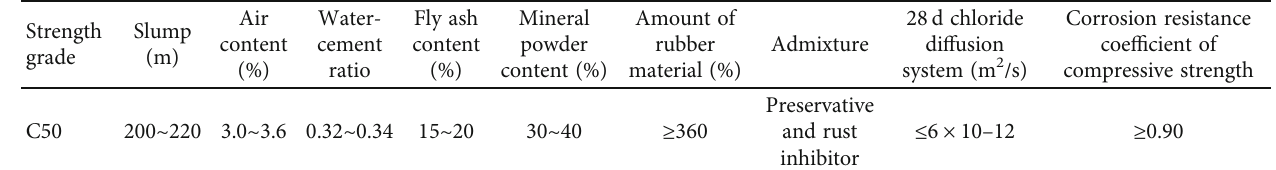
Table 3: Mix proportion design index of the cast-in-place concrete